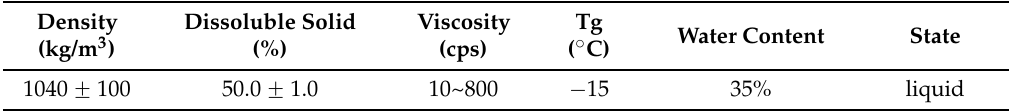
Table 3. Properties of acrylic polymer emulsion resin.